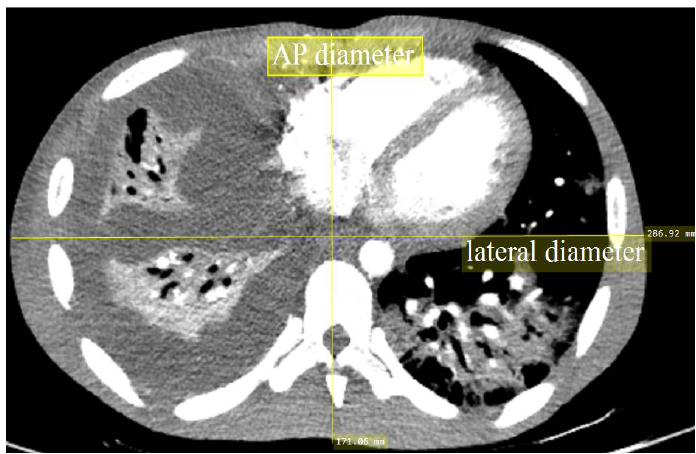
Figure 1. Patient′s size measurement at the mid-slice location of the transverse CT images. Figure 1. Patient (cid:48) s size measurement at the mid-slice location of the transverse CT